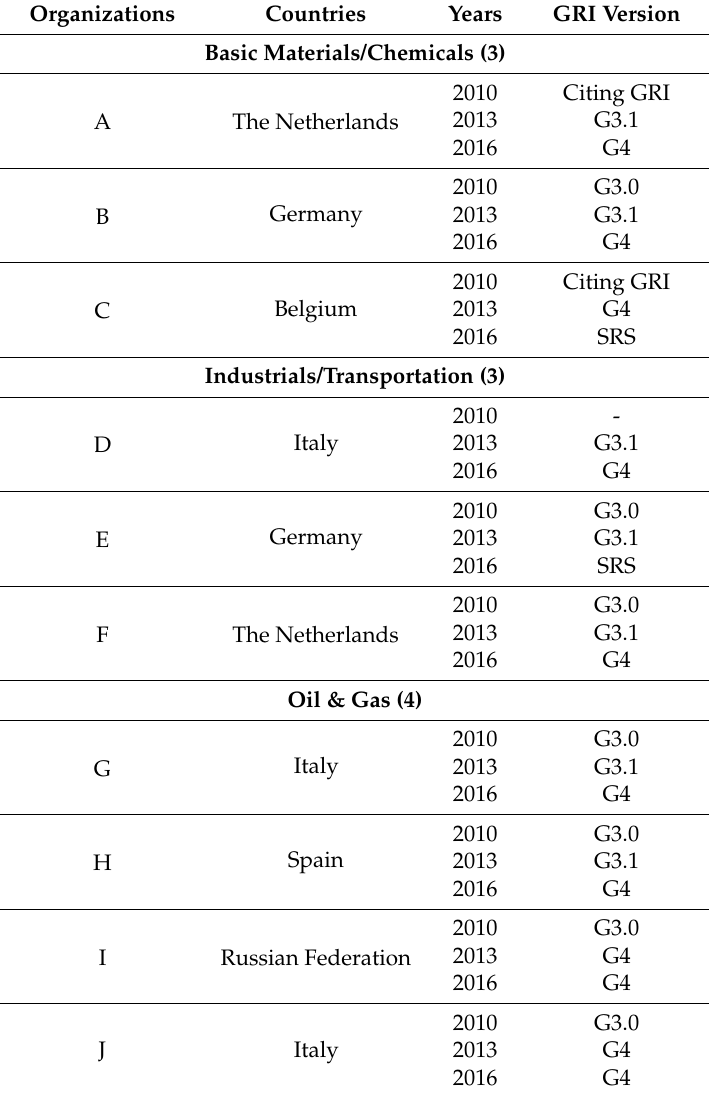
Table A1. Environmentally-sensitive